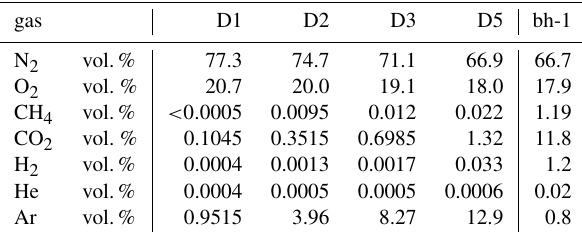
Table 1. Chemical composition of borehole gas D1, D2, D3, D5 as well as of